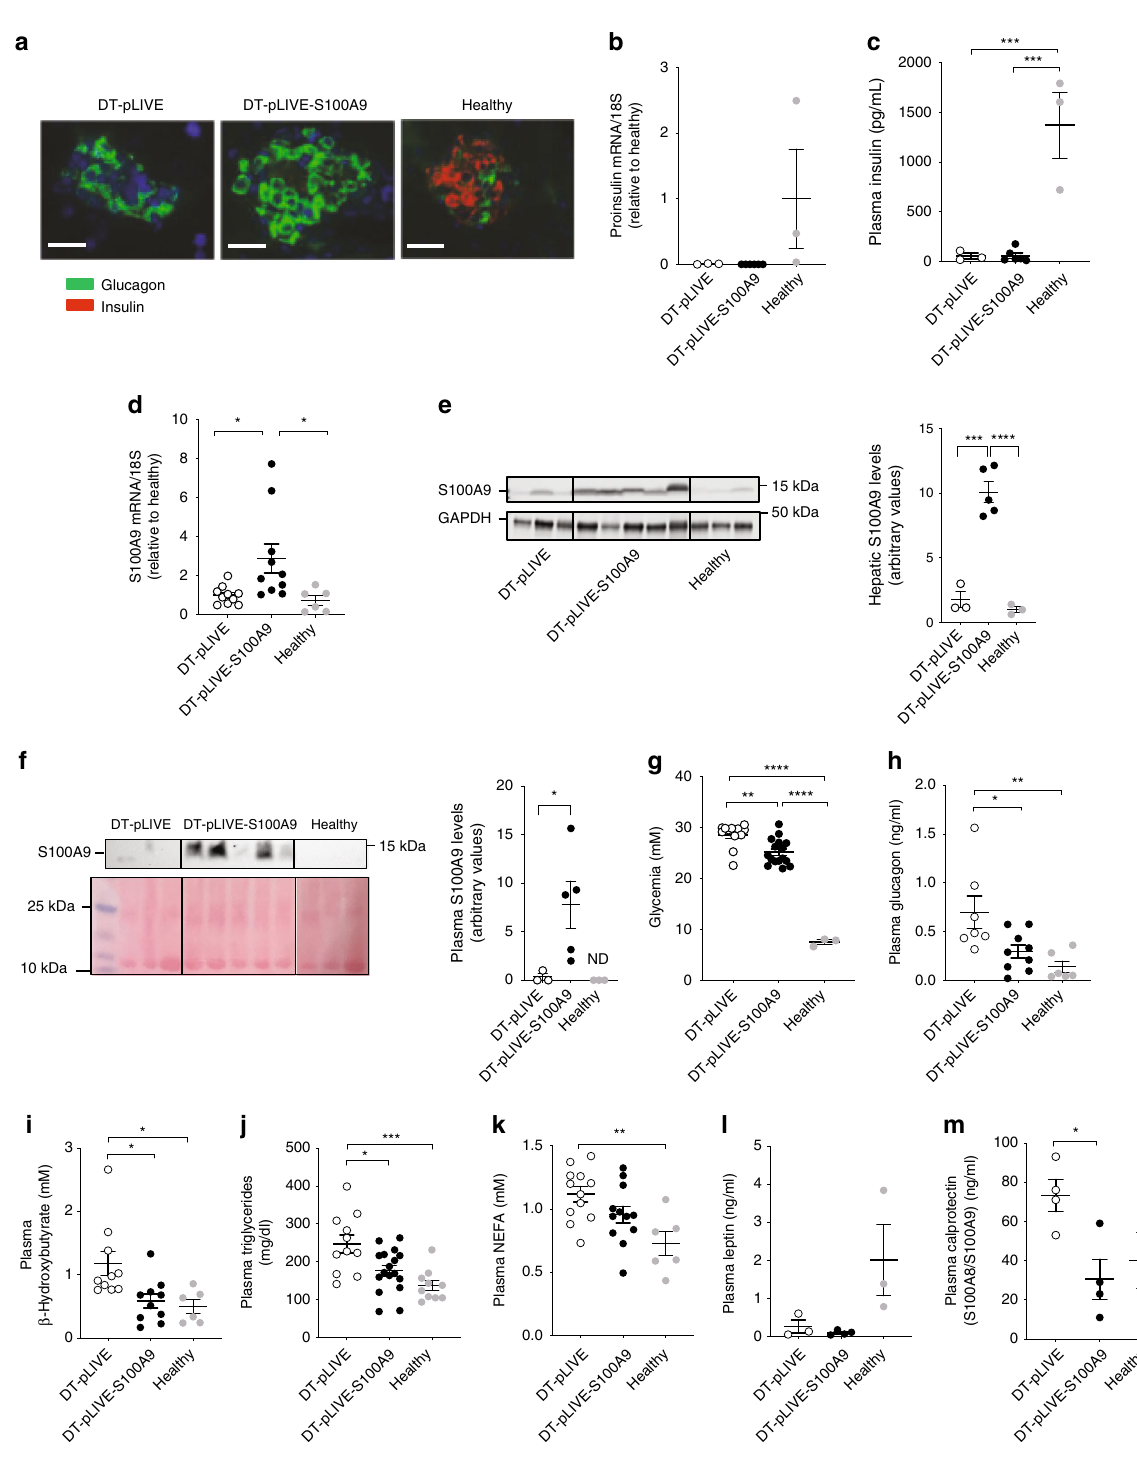
Fig. 3 S100A9 ameliorates metabolic imbalance in DT-induced ID mice. a Immunohistochemistry of pancreatic islets showing insulin (red) and glucagon (green) in DT-treated RIP-DTR mice (sacri fi ced 10 days after HTVI) and their age-matched non-diabetic healthy controls. Scale-bar is 50 µ m. In DT-pLIVE and DT-pLIVE-S100A9 (10 days after HTVI) and their age-matched healthy controls: b proinsulin mRNA content ( n /group = 3, 6, and 3); c plasma insulin content ( n /group = 3, 6, and 3); d hepatic S100a9 mRNA ( n /group = 10, 10, and 6); e hepatic S100A9 levels ( n /group = 3, 5, and 3); f plasma S100A9 levels ( n /group = 3, 5, and 3); g glycemia ( n /group = 11, 15, and 3); h plasma glucagon levels ( n /group = 7, 9, and 6); i plasma β -hydroxybutyrate levels ( n /group = 10, 10, and 6); j plasma triglycerides levels ( n /group = 11, 17, and 10); k plasma NEFAs level ( n /group = 12, 12, and 6); l plasma leptin levels ( n /group = 3, 4, and 3); m plasma calprotectin levels ( n /group = 4, 4, and 3). Error bars represent SEM. Statistical analyses were done using one-way ANOVA (Tukey ’ s post hoc test). * P < 0.05; ** P < 0.01; *** P < 0.001, **** P < 0.0001. Western blot results shown in f is a cropped image of the whole gel. Source data are provided as a Source Data fi